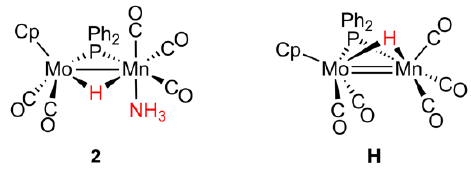
Figure 1. Structure of hydride complexes 2 and H .